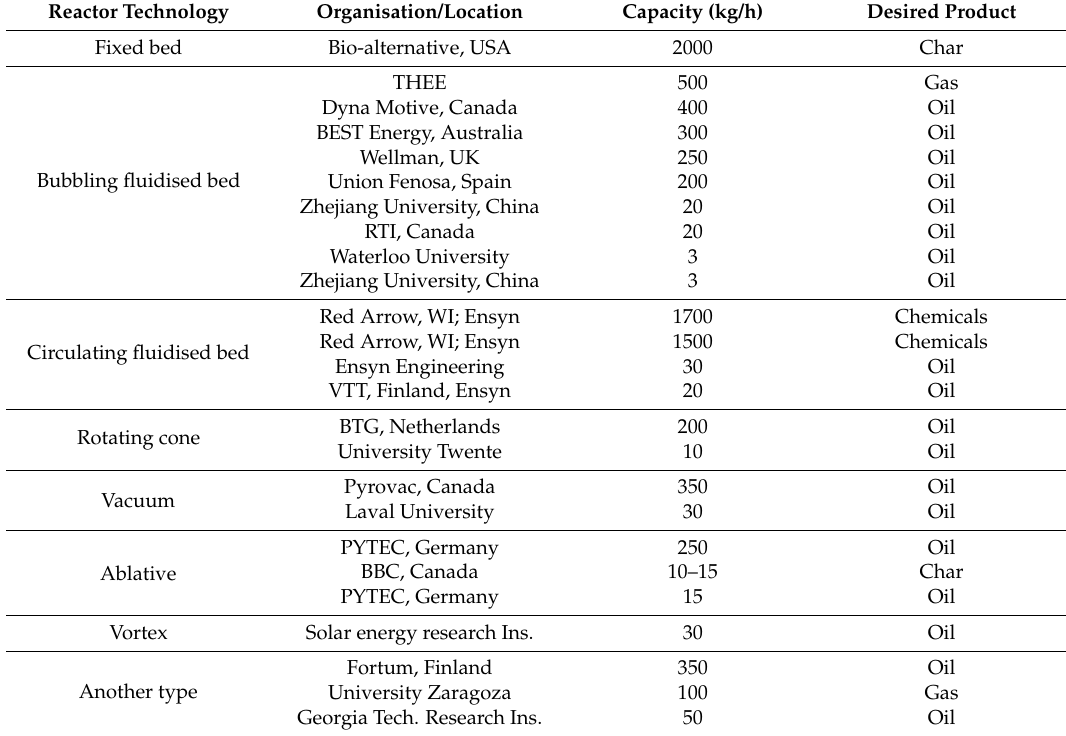
Table 7. Current pyrolysis plants worldwide